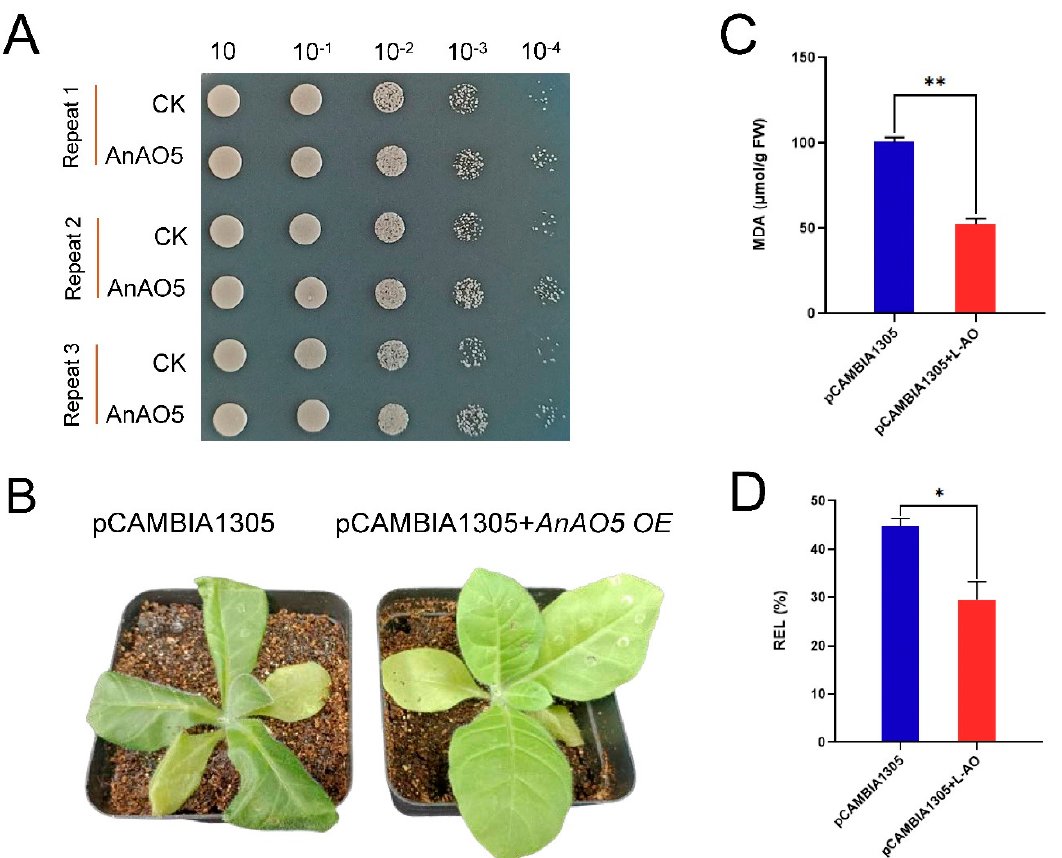
Figure 11. Overexpression of the AnAO5 gene enhanced the tolerance to low temperature in yeast and tobacco seedlings. ( A ) Overexpression of AnAO5 gene enhanced the tolerance to repeated freeze–thaw stress in yeast. ( B ) Tobacco seedlings transiently expressing the empty vector (control) and tobacco seedlings transiently expressing AnAO5 gene were transferred to a − 4 °C plant incubator for low temperature treatment for 24 h. ( C ) The MDA content of tobacco leaves after low-temperature treatment. ( D ) The values of REL of tobacco leaves after low-temperature treatment. Values are expressed as means ± SD ( n = 3), and the statistically significant differences were evaluated using Student’s t -test, * p < 0.05, ** p <